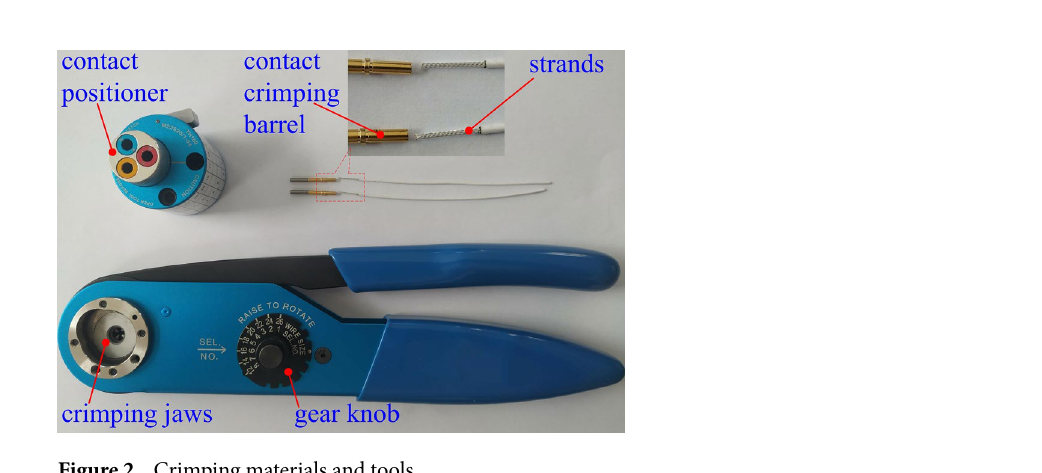
Figure 1. Four-indenter-eight-indentation crimping method for AWH end contacts.